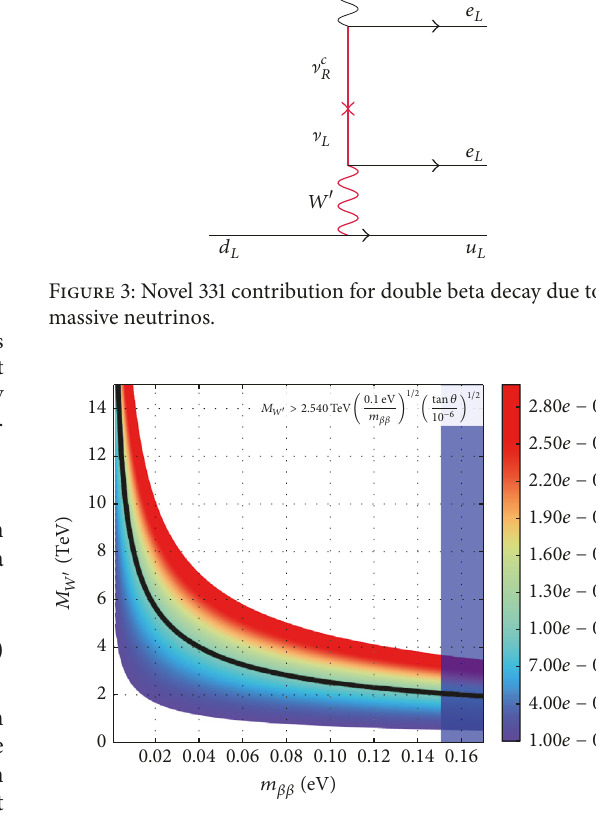
Figure4:Temperatureplotofthelowermassboundonthe 𝑊 耠 mass as function of 𝑚 훽훽 and tan 𝜃 . The black curve is drawn simply to guide the eye and check that, indeed for tan 𝜃 ∼ 10 −6 and 𝑚 훽훽 ∼ 0.1 eV, we find the lower mass bound 𝑀 ≳ 2.5 푊 󸀠